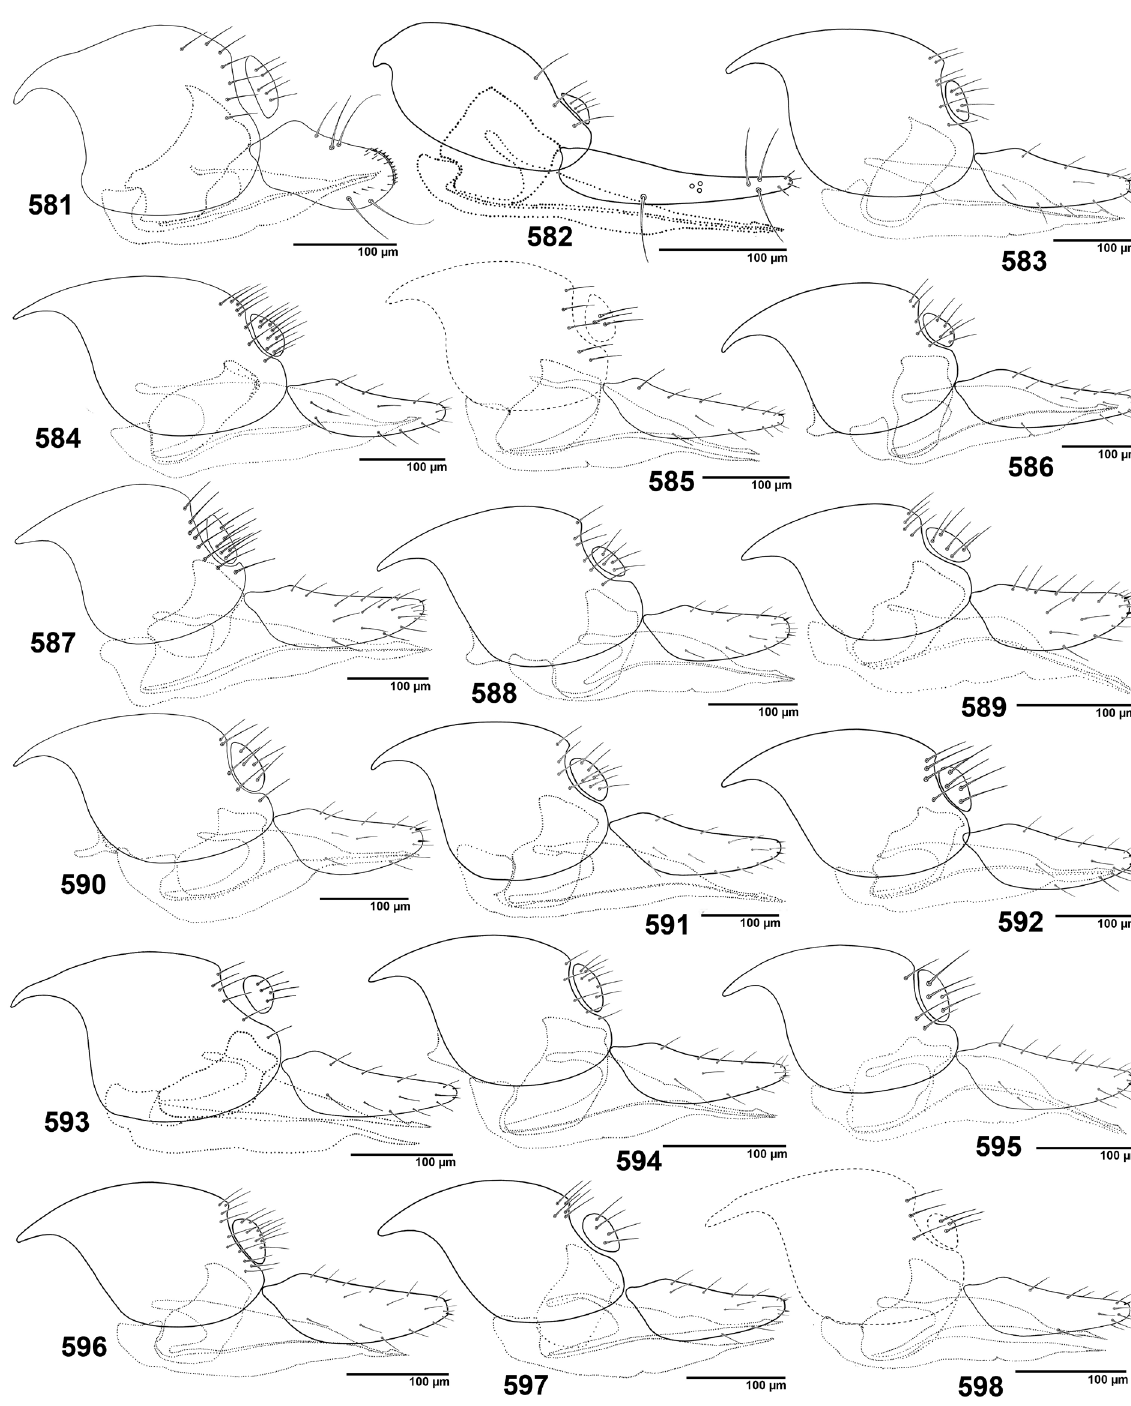
Figs 581–598. Lateral aspect of ♀ genitalia: 581 . Pauesia silana . 582 . Pauesia unilachni . 583 . Praon abjectum . 584 . Praon absinthii. 585 . Praon athenaeum . 586 . Praon barbatum . 587 . Praon bicolor . 588 . Praon exsoletum . 589 . Praon flavinode . 590 . Praon gallicum . 591 . Praon longicorne . 592 . Praon necans . 593 . Praon nonveilleri . 594 . Praon orpheusi . 595 . Praon pubescens . 596 . Praon rosaecola . 597 . Praon unitum . 598 . Praon uroleucon